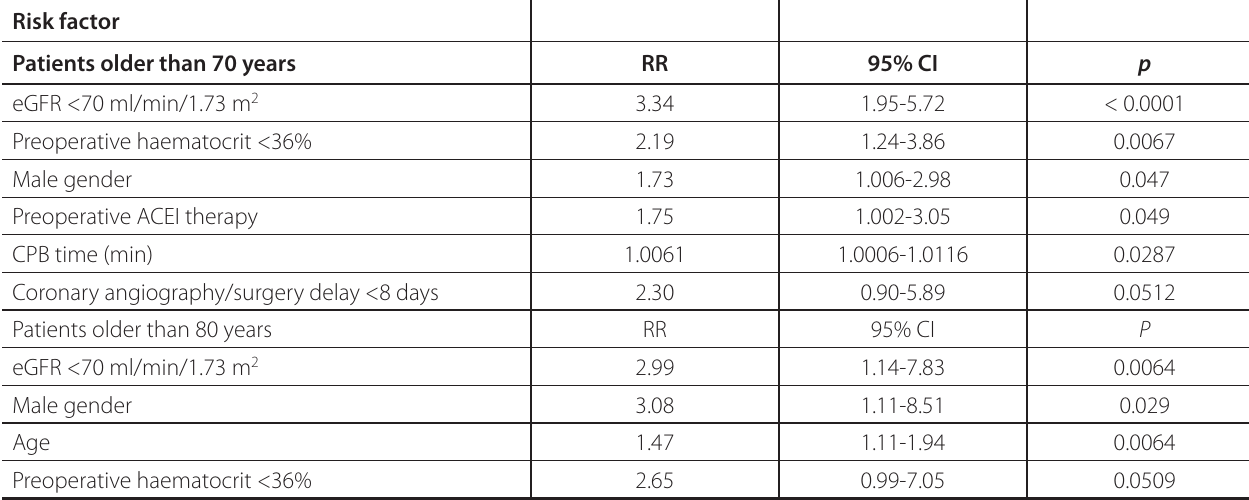
Table 5 . Risk factors for AKI after heart valve surgery in patients older than 70 and 80 years (multivariate analysis). Risk